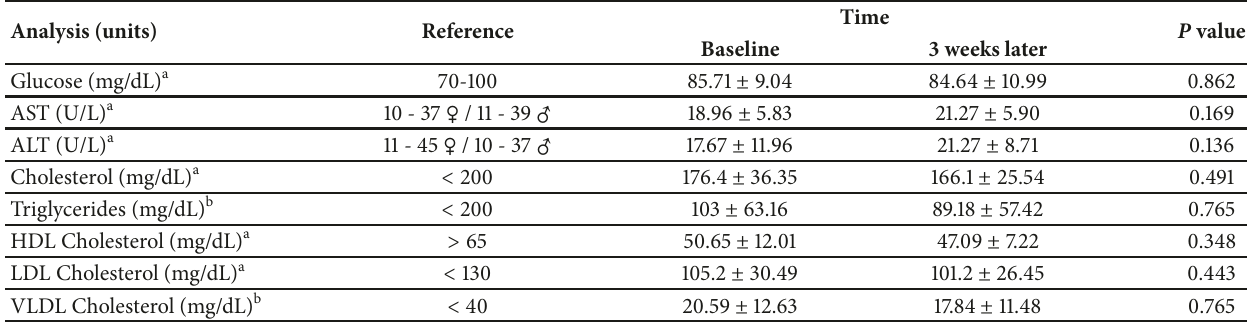
Table 1: Mean (SD) for fasting glycemia, serum liver test, and serum lipid